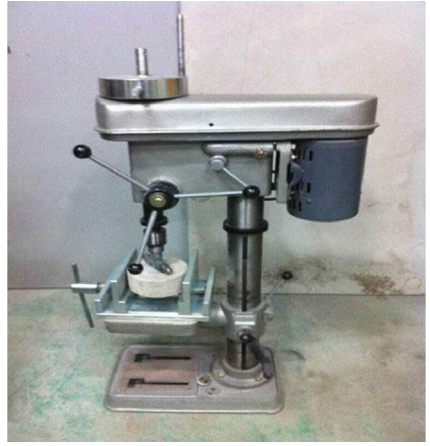
Figure 4: Abrasion test setup